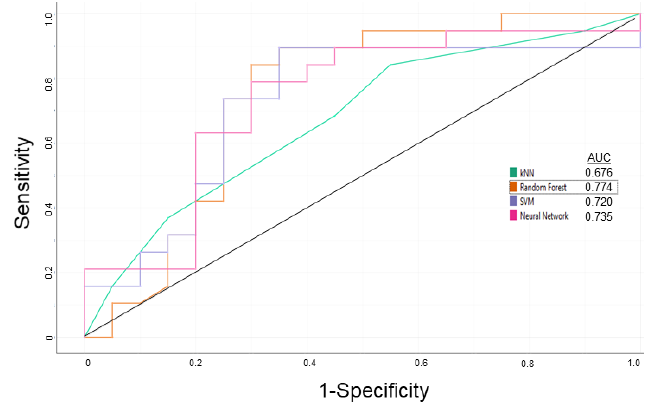
Figure 2. ROC curves of kNN, Neural Network, RF, and SVM classification algorithms based on random leave-one-out sampling for the P-gp inhibitor / substrate prediction model for the learning step. Table 4. Performance of the P-gp inhibitor / substrate prediction model based on the RF classifier algorithm.